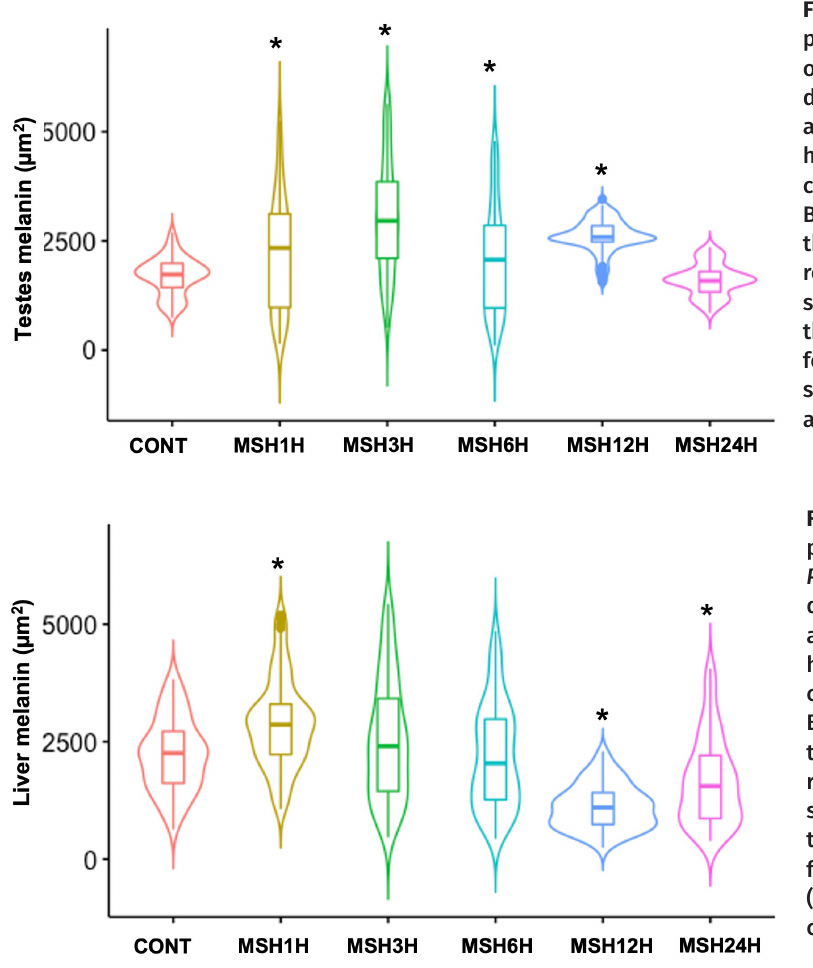
Figure 6. Effect of α-MSH in the pigment-containing area of liver of P. nattereri , showing the melanin dispersion variation within cells, analyzed after 1, 3, 6, 12 and 24 hours after hormonal treatment, compared with the control group. Box represents the first and third quantiles and lines inside represent the median. Violin showing the data distribution and the points the outliers. ANOVA followed by Tukey test ( P <0.05). (*) shows differences between control and treated